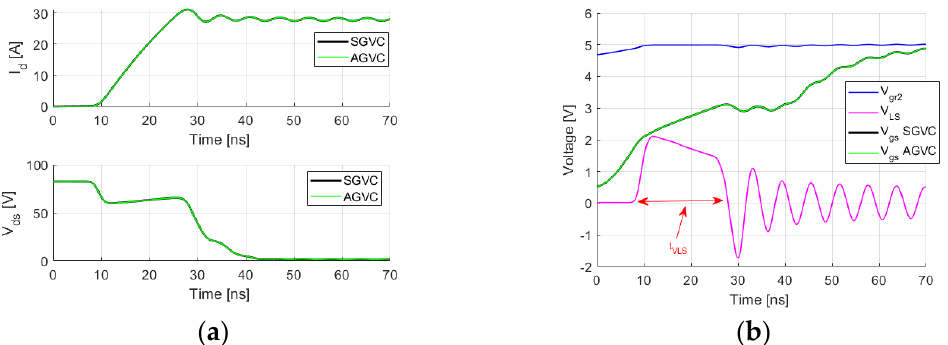
Figure 14. Simulated waveform of the main voltage and current using the proposed closed-loop active gate voltage circuit (AGVC) and standard gate voltage control (SGVC) (I d = 28 A, L s = 1 nH), ( a ) V ds and I d , ( b ) V Ls , V gr2 , V gs of AGVC, and V gs of